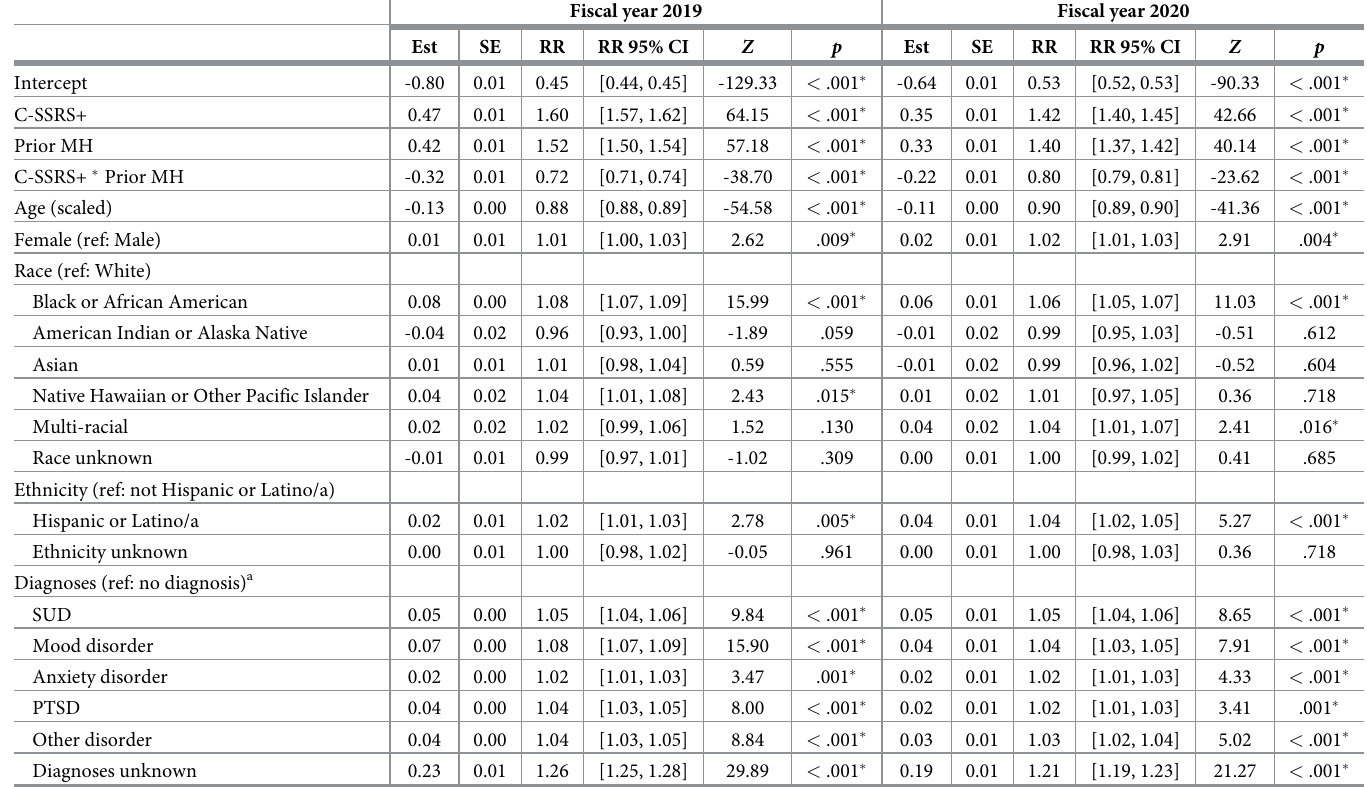
Table 2. Timely mental health follow-up (1+ visits within 30 days of